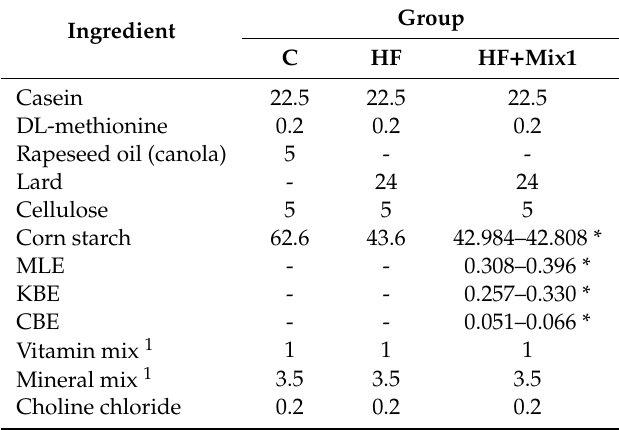
Table 6. Composition of the diets fed to rats for 10 weeks at the proper stage of the